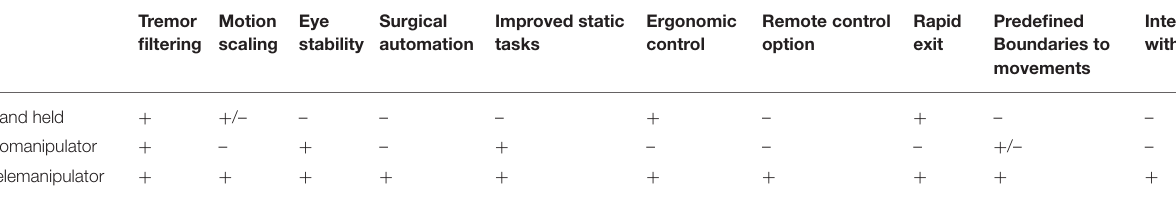
TABLE 3 | Advantages and drawbacks of robotics designs for subretinal delivery.